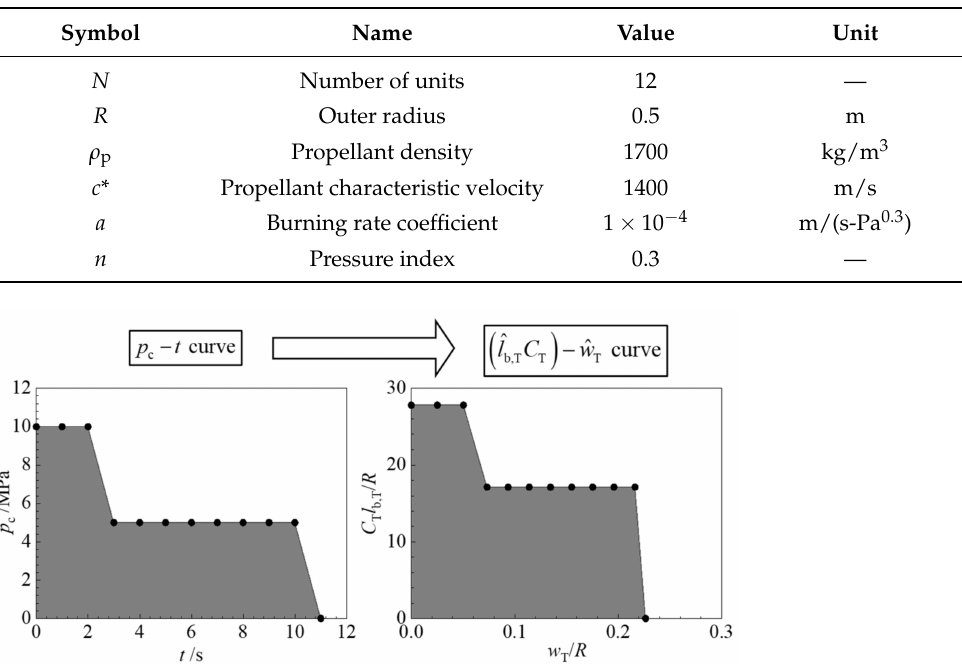
Table 5. Parameters of the dual-thrust grain.